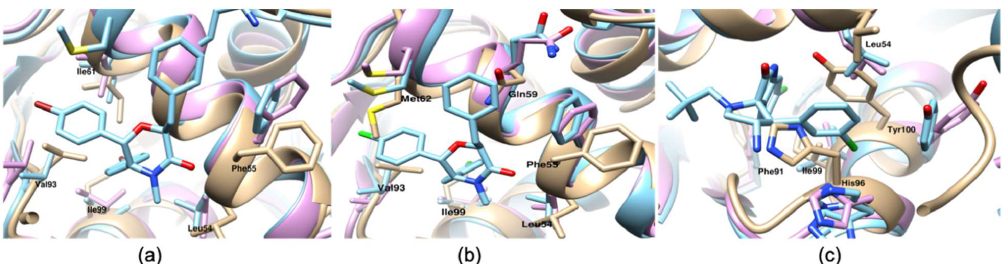
Figure 4. The structural comparison between apo-MDM2 crystal structure (PDB ID:1Z1M, golden color), holo-MDM2 used as start structure for free energy simulation (light blue color), and final structure obtained after simulation (hot pink color). ( a ) The protein-ligand complex (compound 13); ( b ) the protein-ligand complex (compound 14); ( c ) the protein-ligand complex (compound10). The interacting residues are highlighted and labelled in black